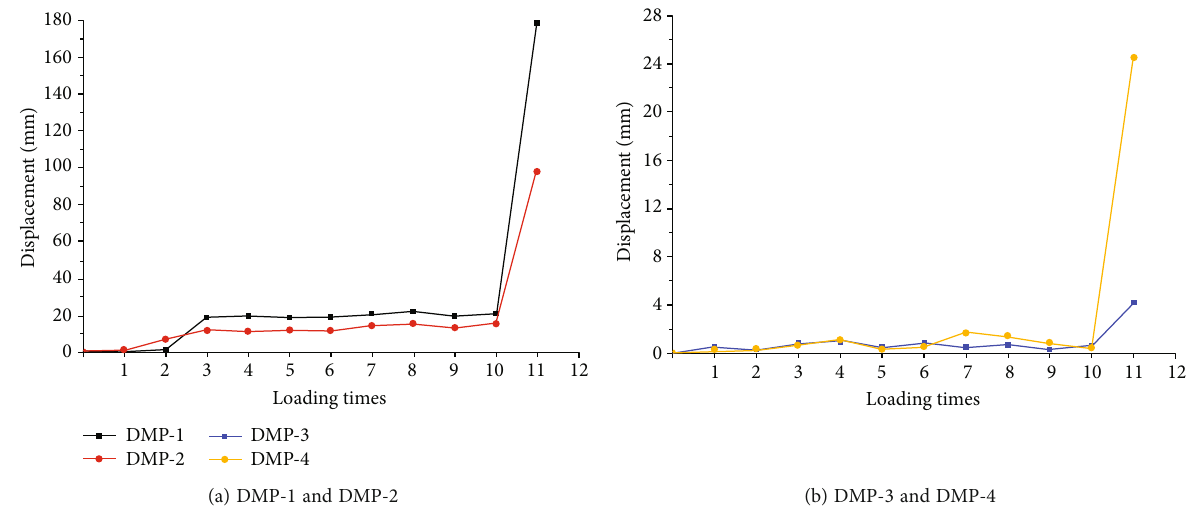
Figure 13: Monitoring points displacement curves with loading